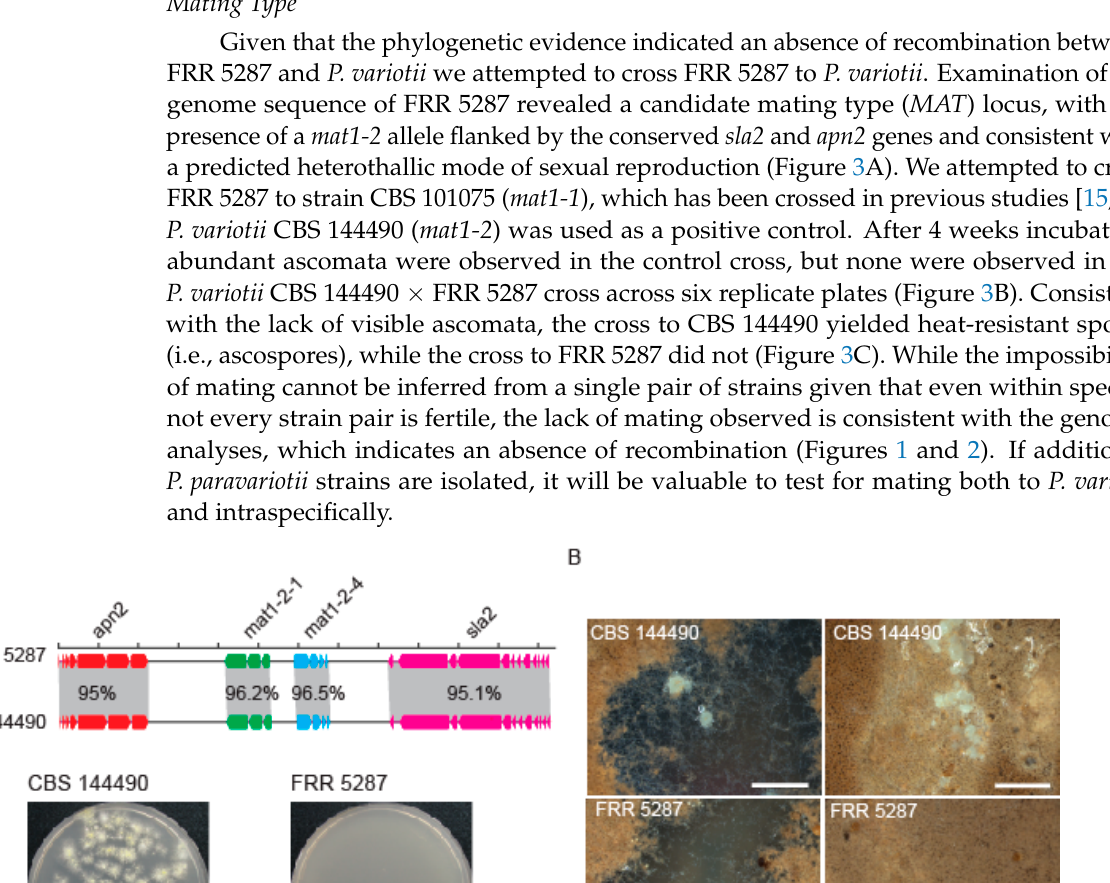
Figure 2. Genome-wide assessment of divergence between P. variotii and P. paravariotii using a BLAST all-vs.-all approach. Each comparison is to the P. variotii CBS 144490 gene regions. Blue col- our indicates genes contained within the HEPHAESTUS transposable element.